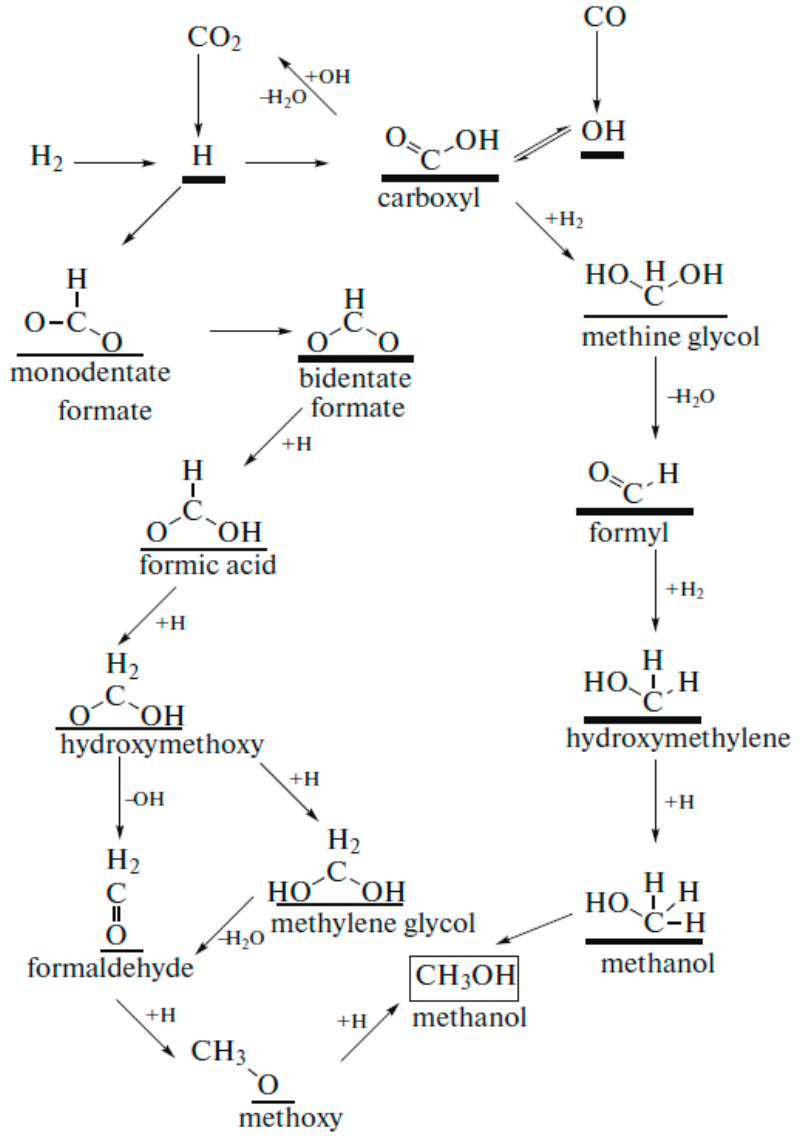
Figure 10. Proposed stepwise mechanism of CO 2 and CO transformations under conditions of methanol synthesis on copper-containing catalysts. Reprinted with permission from ref. [256]. Copyright